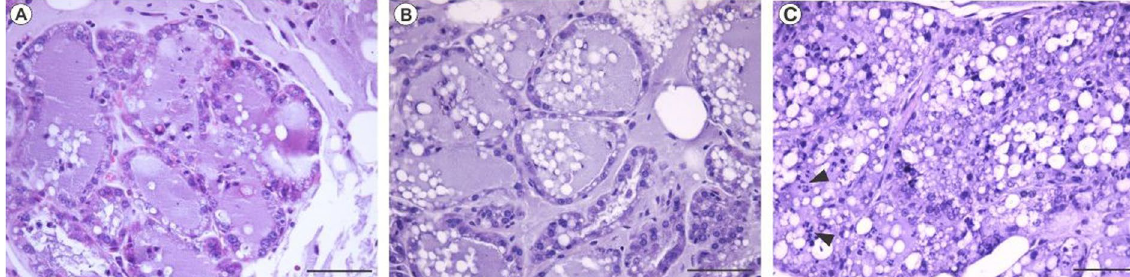
Figure 7. Histological analysis of mammary gland after PBS ( A ), E. coli 30 ( B ) and treatment with vB_EcoM- UFV13 ( C ). In C, neutrophil infiltration (indicated by arrow head) was detected 48 hours after phage treatment using MOI 10. Bars: 100